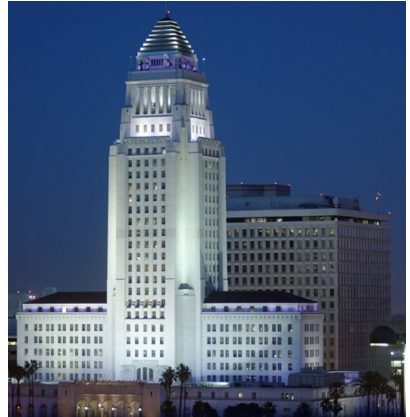
Figure 4. Los Angeles City Hall